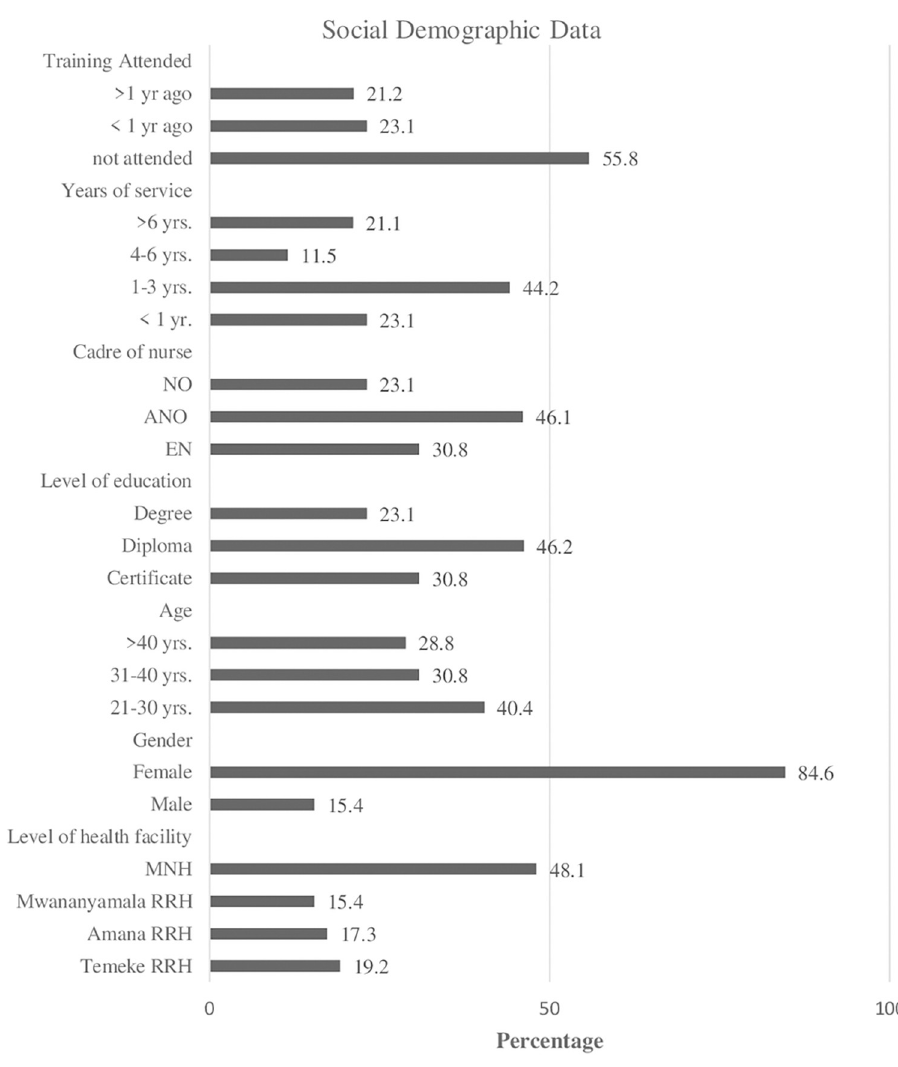
Fig 1. Social demographic